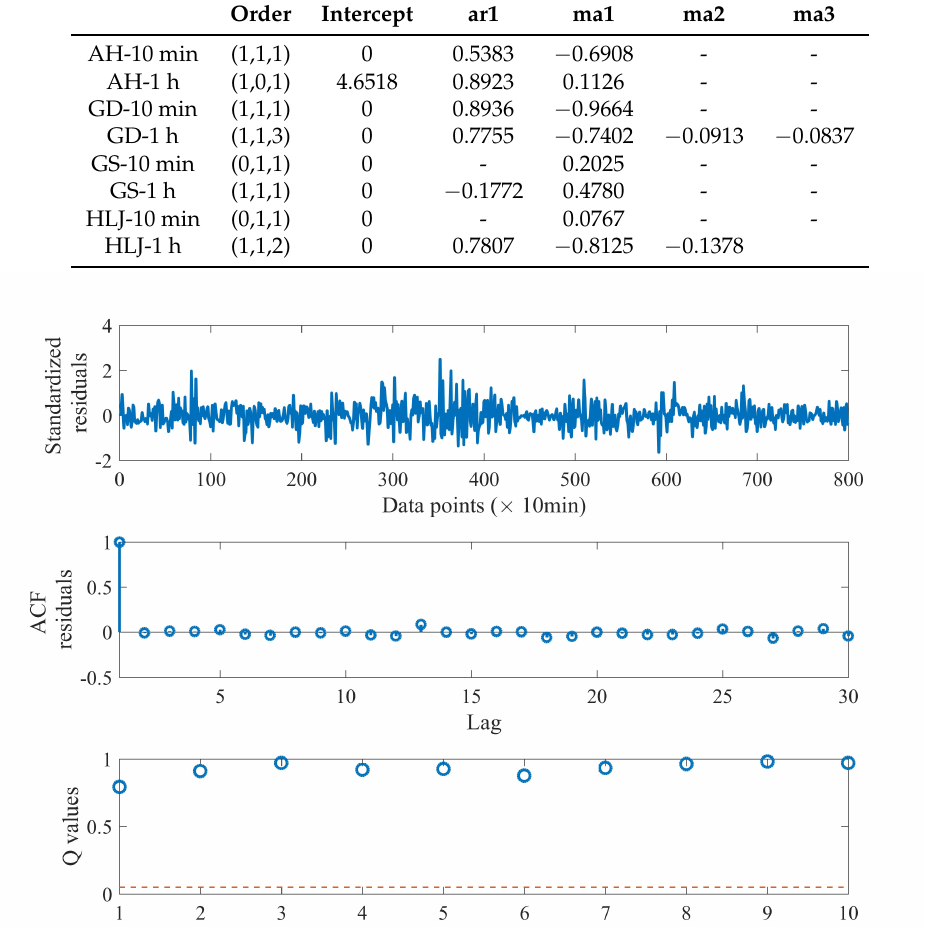
Table 3. Single ARIMA model parameters of various wind speed datasets.